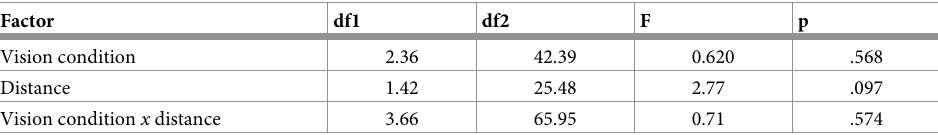
Table 18. Results of the two-factor ANOVA with repeated measures (3 distances; 4 vision conditions) for absolute error of the predicted putt length. Corrected by Greenhouse-Geisser � . Factor df1 df2 F p Vision condition 2.36 42.39 .568